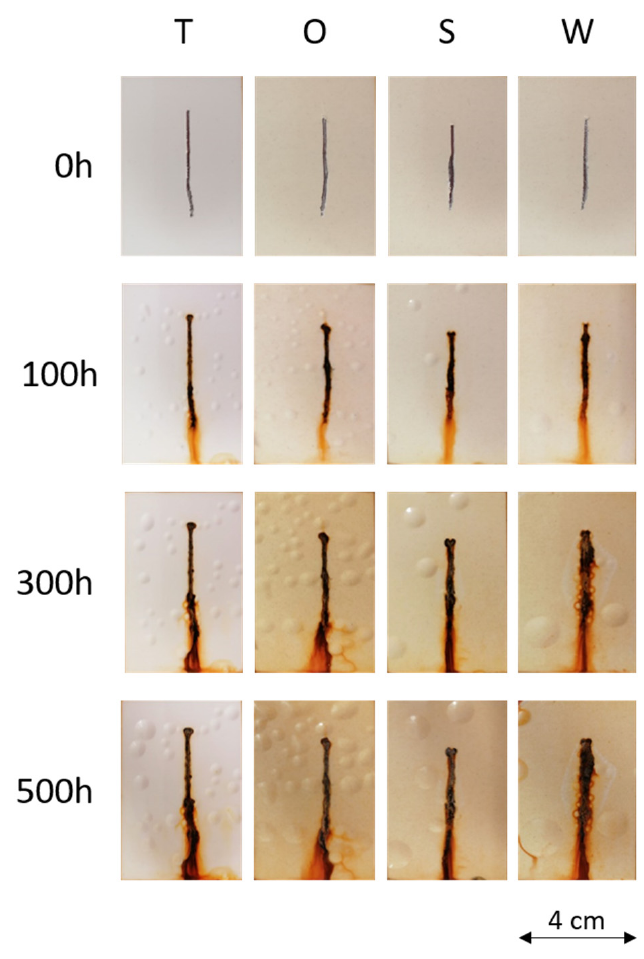
Figure 5. C oatings’ degradation during the exposure in salt spray